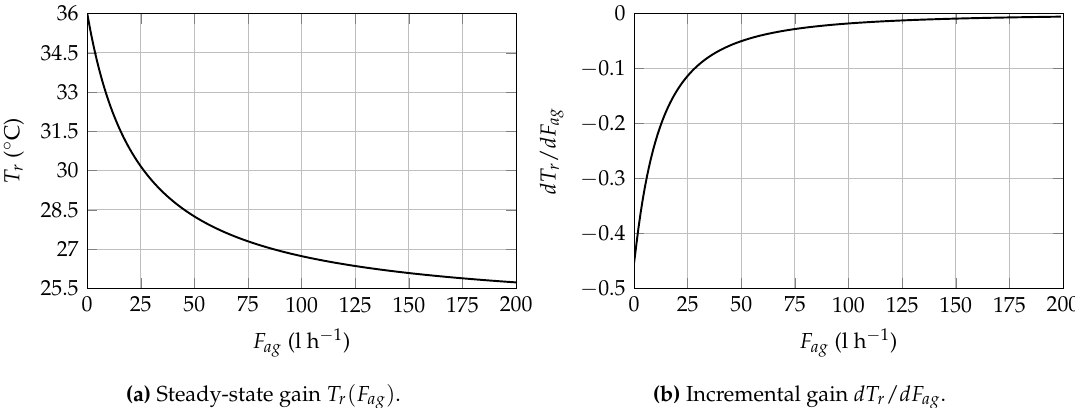
Figure 5. Steady-state gain and Incremental gain variation in the Yeast Fermentation Reaction Temperature Control problem.